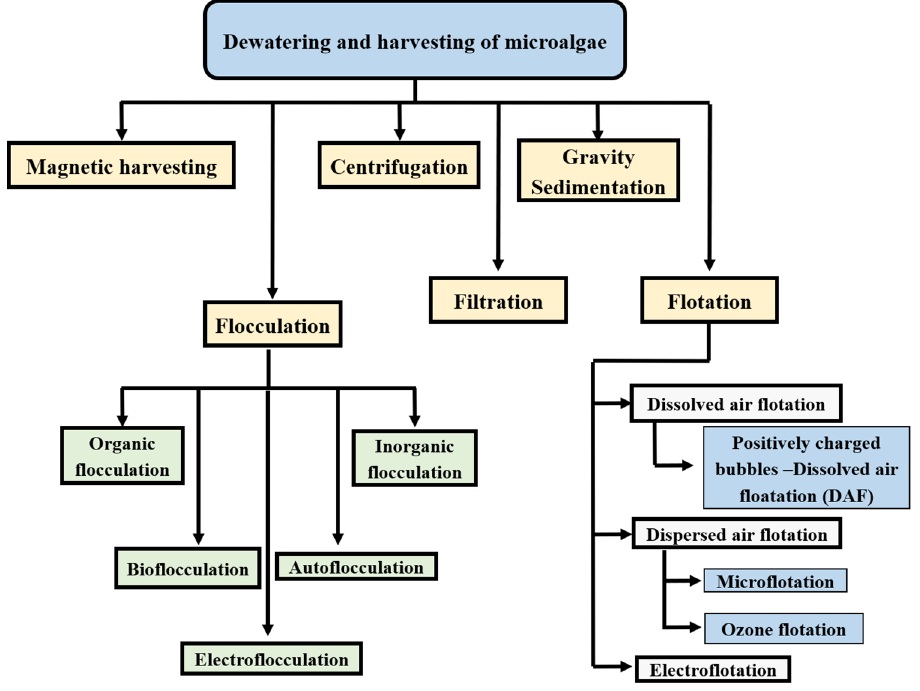
Figure 1. Conventional microalgae harvesting and dewatering methods.